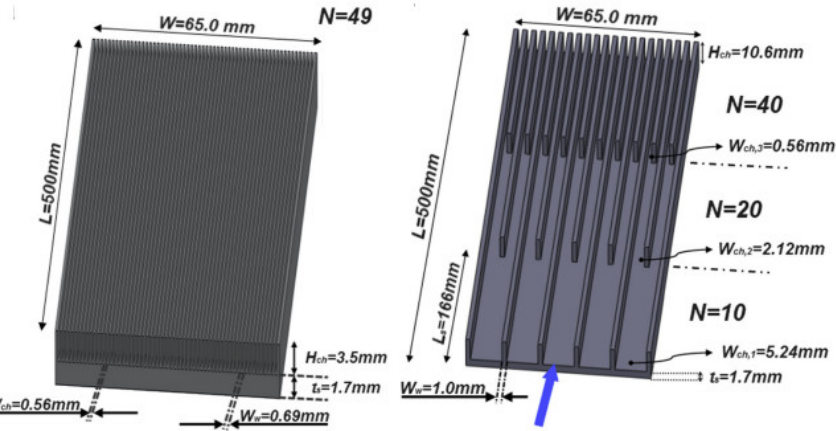
Figure 29. Designs of microchannel heat receivers tested in [28]. Left: constant width of channels, right: stepwise-varying width. The direction of flow is marked with blue arrow. Reprinted with permission from Ref. [28]. 2017, Elsevier.